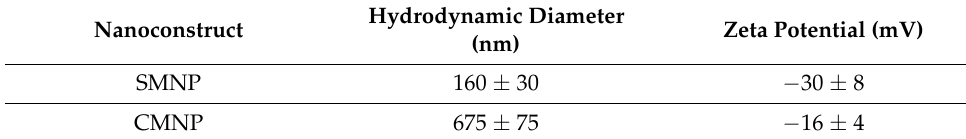
Figure 2. Schematic representation of the SMNP synthesis. Table 1. Physicochemical properties of the magnetic nanoparticles (MNPs).